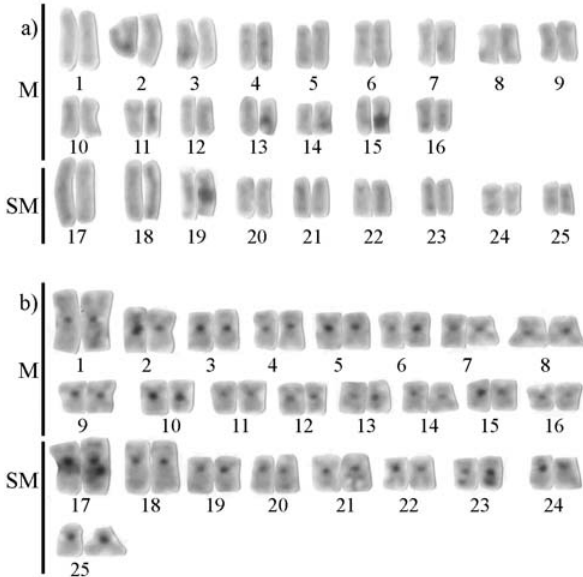
Figure 3 - C-banding Karyotypes of (a) Characidium gomesi and (b) Characidium cf. zebra from the Machado